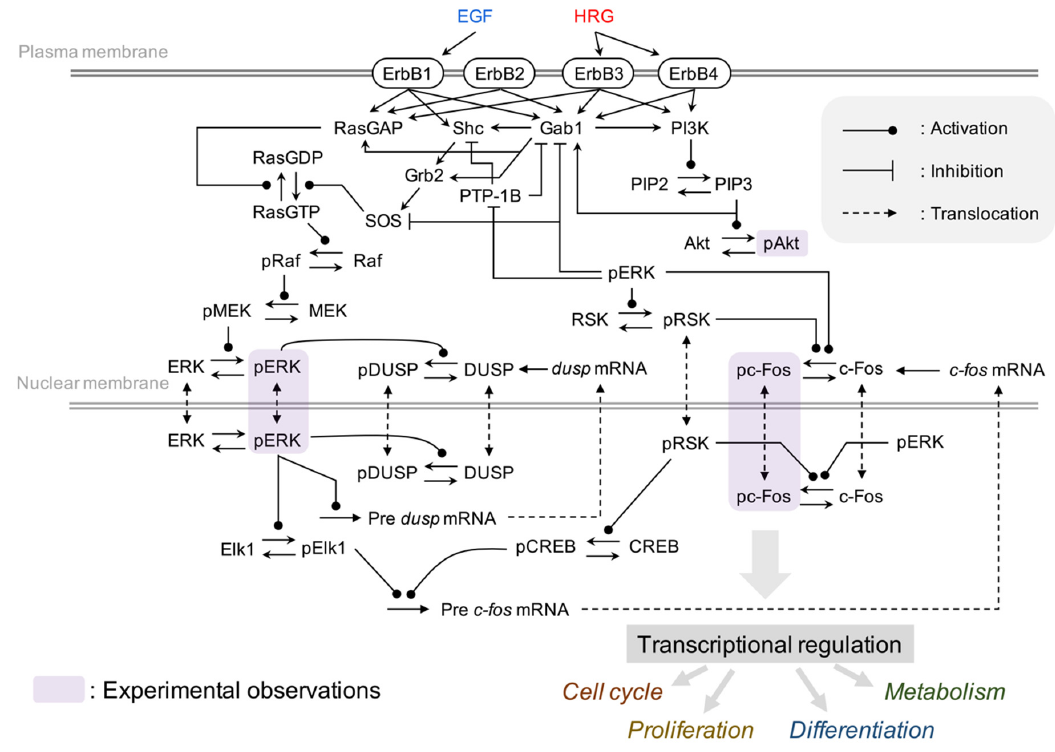
Figure 2. Influence diagram of the molecular interactions implemented in the model.